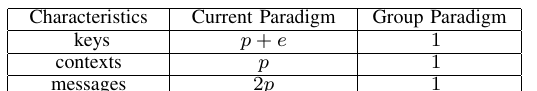
TABLE V P ERFORMANCES OF THE DISCONNECTION